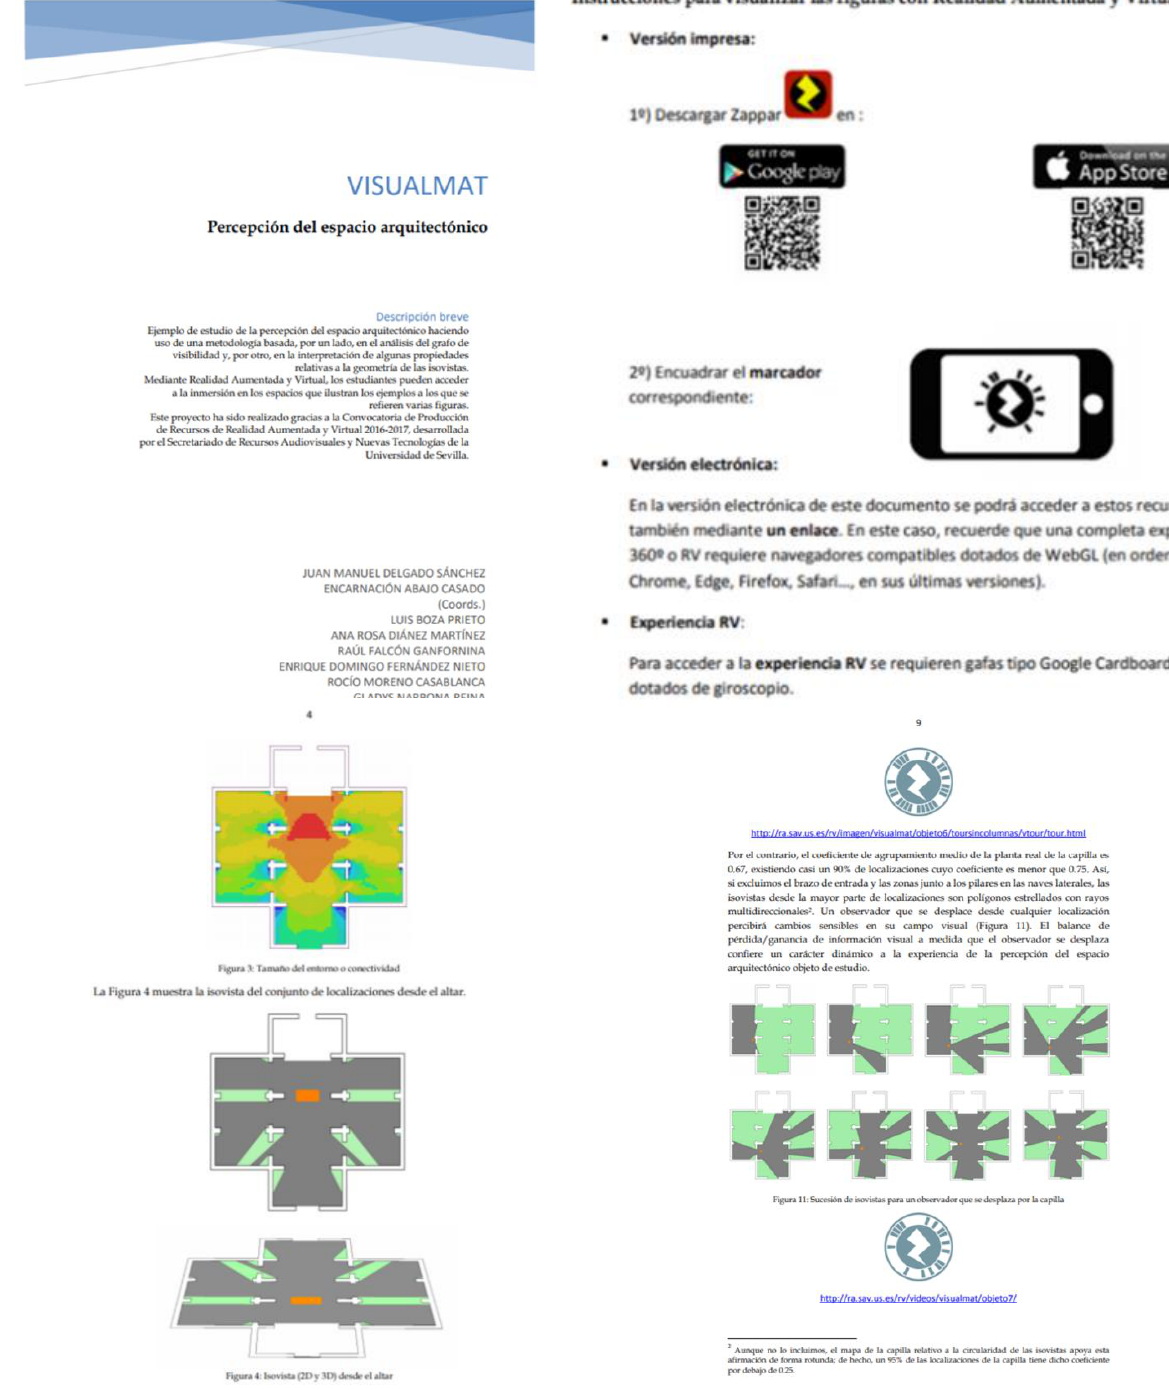
Figure 5. Images of the accompanying